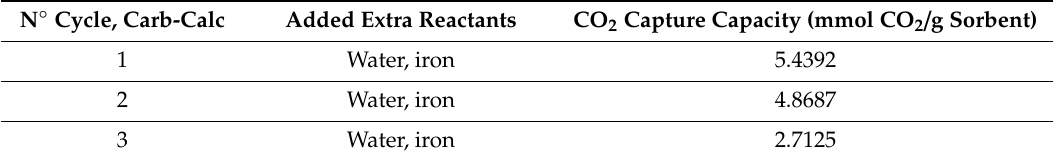
Table 5. CO 2 capture capacity for several cycles of carbonation–calcination using the HTHP process.